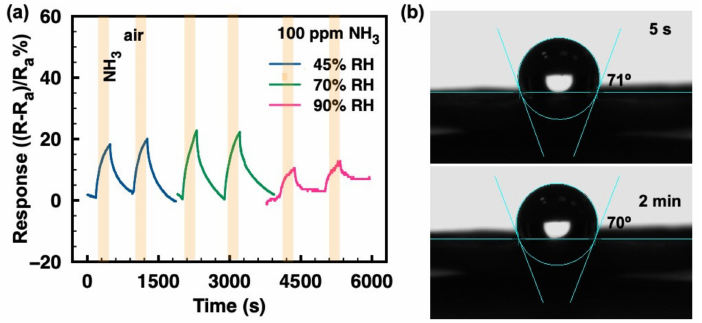
Figure 4. ( a ) Relative response vs. time to 100 ppm ammonia gas under different humidity atmospheres (45%, 70%, and 90%); ( b ) The contact angles of water droplets on the ZIF-8/CNT sample